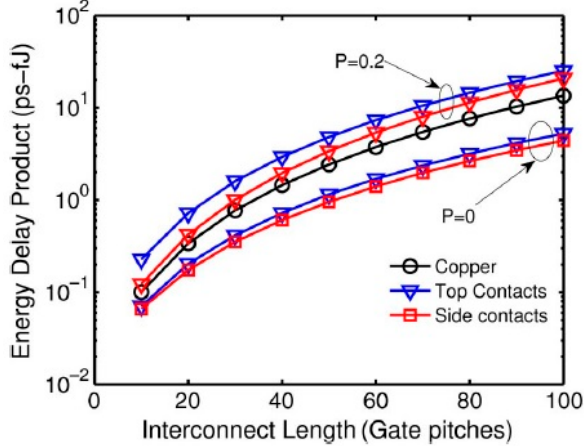
Figure 20. EDP of Cu and MLGNR interconnects as a function of interconnect length [7]. Reproduced with permission from [7]. IEEE, 2012.